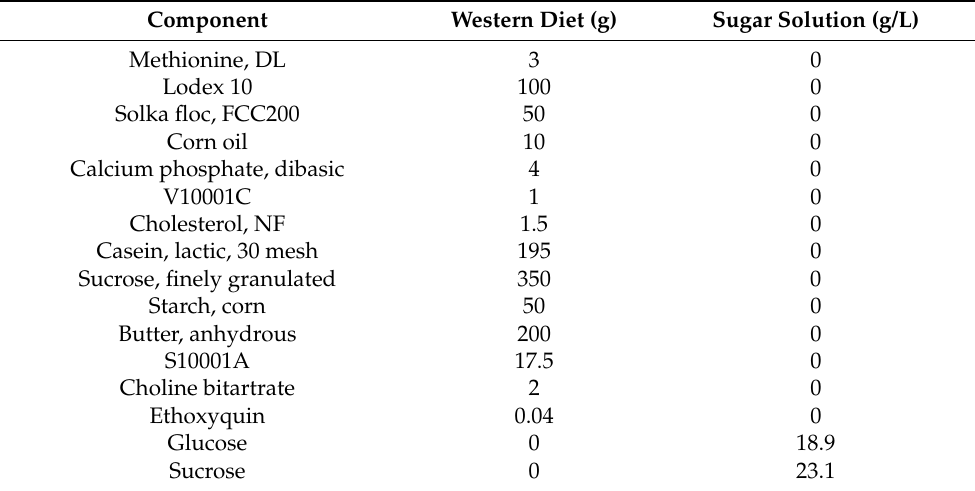
Table 1. Composition of the fast food